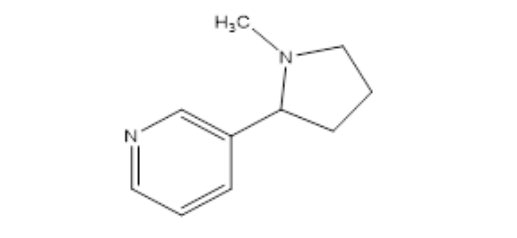
Figure 1. Structure of